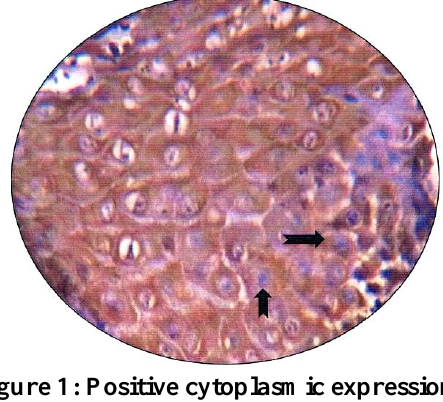
Figure 1: Positive cytoplasmic expression of